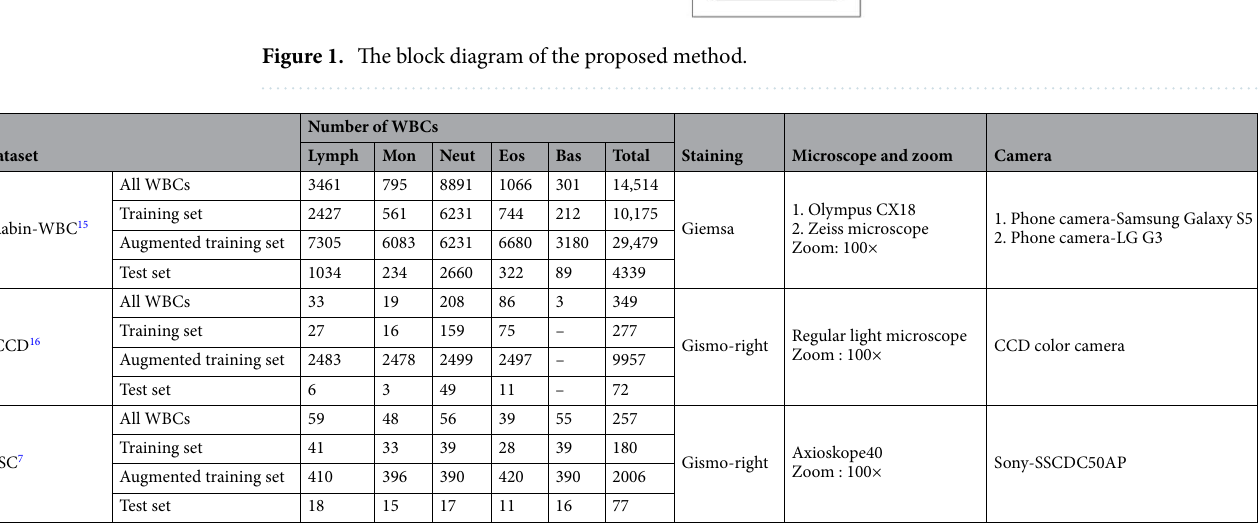
Table 1. The properties of LISC, BCCD, and Raabin-WBC